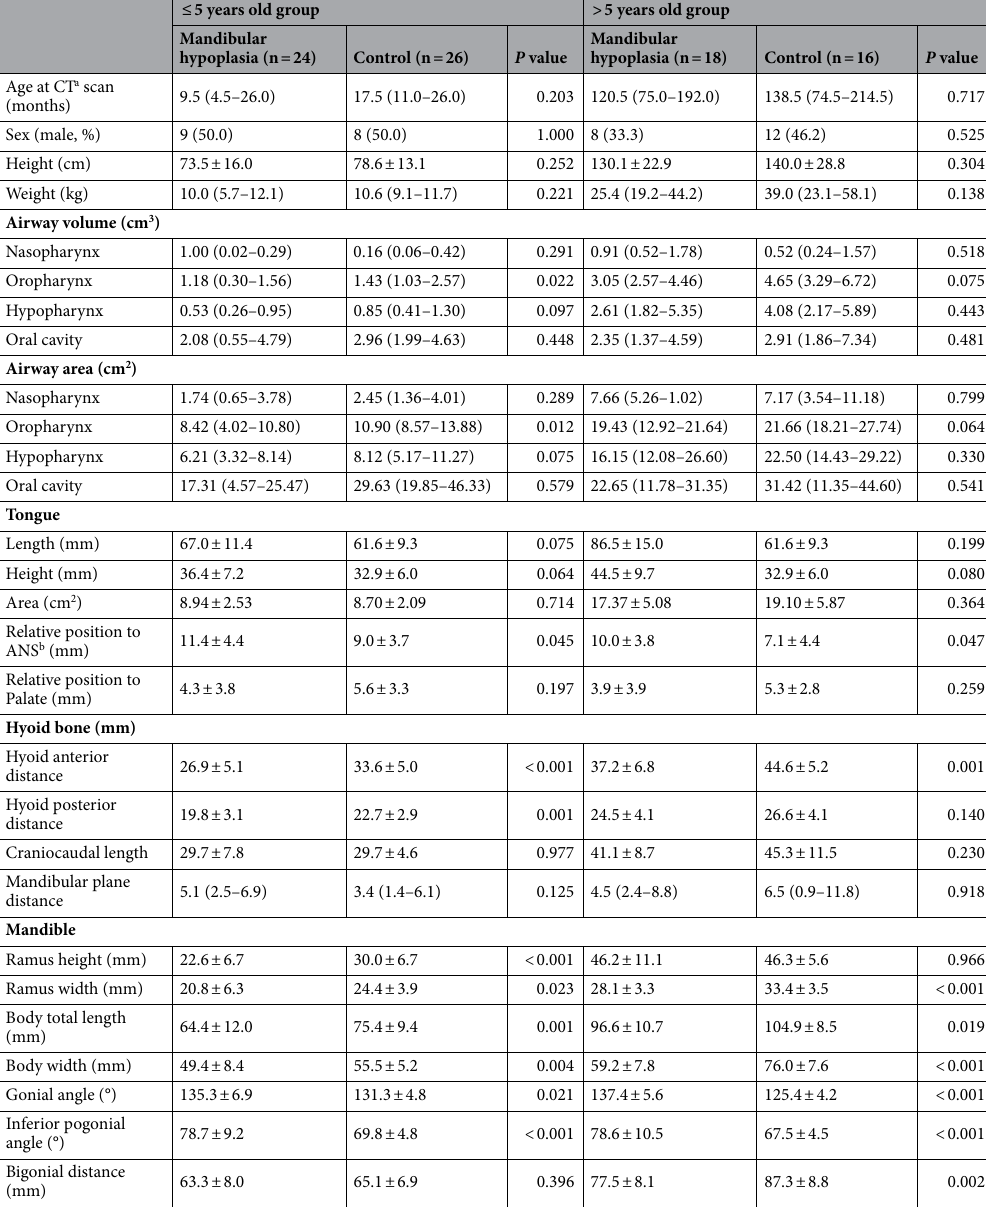
Table 2. Clinical characteristics and three-dimensional computed tomographic measures of upper airway between the mandibular hypoplasia and control groups, stratified by stage of dentition. Values are mean ± (standard deviation) or median (interquartile range). a CT Computed tomography. b ANS Anterior nasal